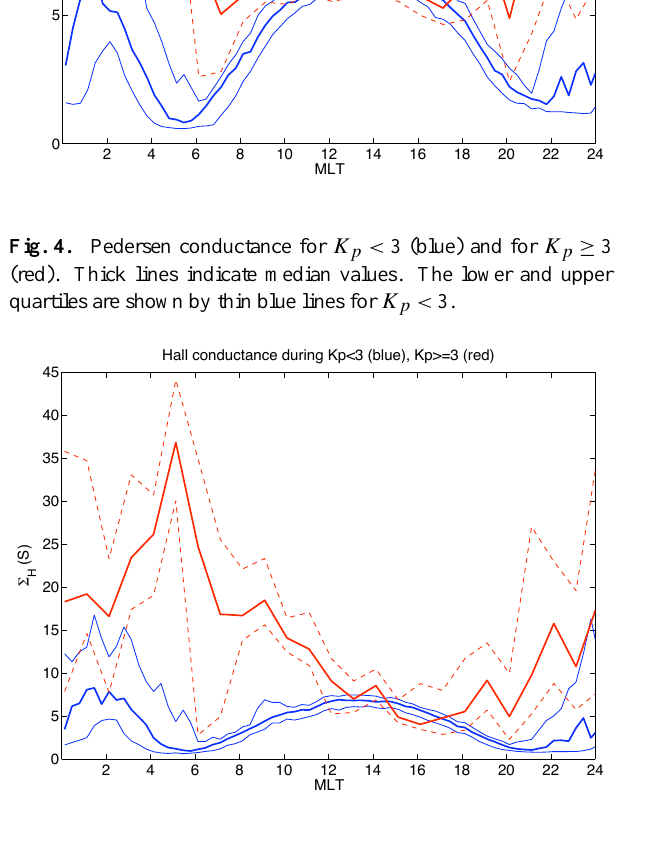
Fig. 5. Hall conductance in the same format as Fig. 4. for low-activity case and thin red dashed curves for the high- activy case). The low activity curves resemble the median curve in Fig. 3 showing a single nightside enhancement with a maximum at 01 MLT. As activity increases, the Pedersen